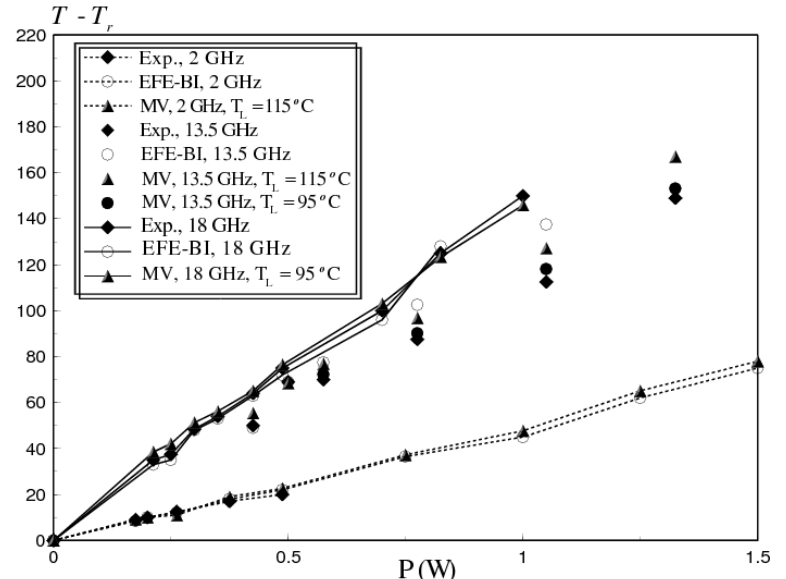
Figure 5. Substructured EM-thermal model predictions versus numerical model results and experimental data reported by Wang et al. [20] of spatially average temperature rise versus input power for fixed-fixed gold beam at frequencies of 2 GHz, 13.5 GHz and 18 GHz ( l = 400 µm , W = 20 µm , t = 2 µm m m m